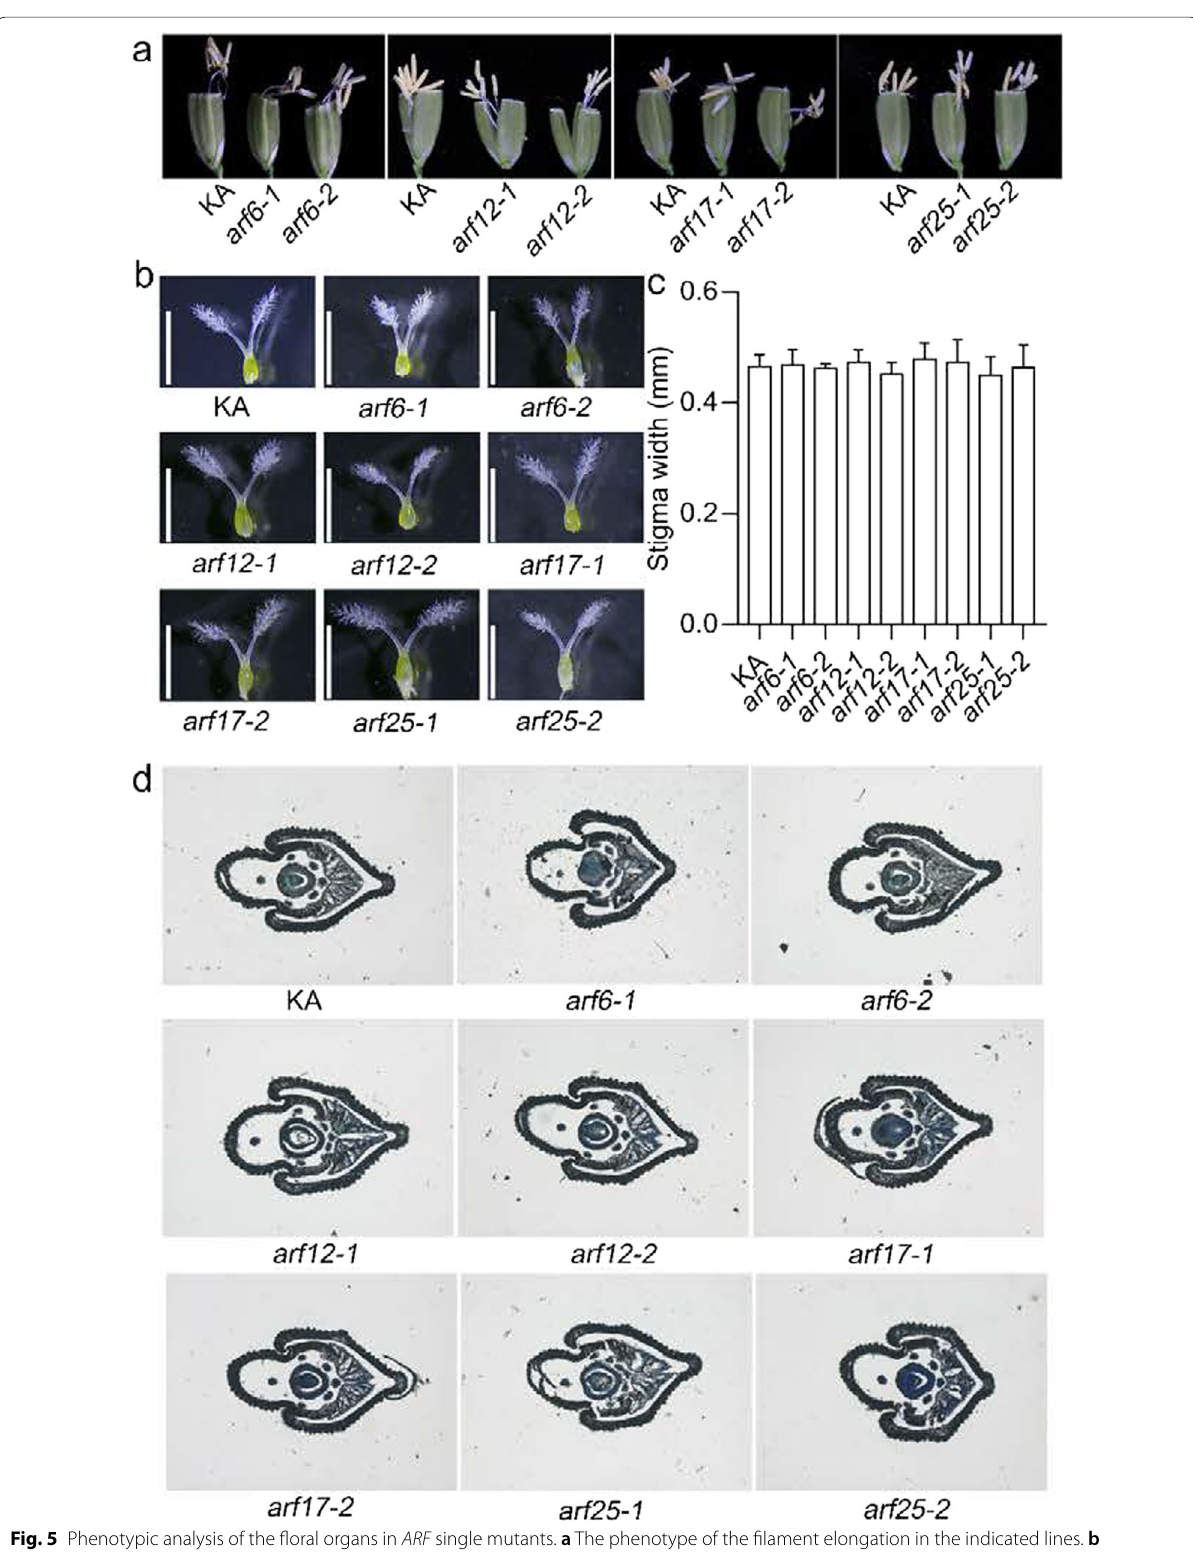
Fig. 5 Phenotypic analysis of the floral organs in ARF single mutants. a The phenotype of the filament elongation in the indicated lines. b Phenotype of the pistils. Bars, 2 mm. c Comparison of the stigma width. Error bars indicate the standard deviation (SD)